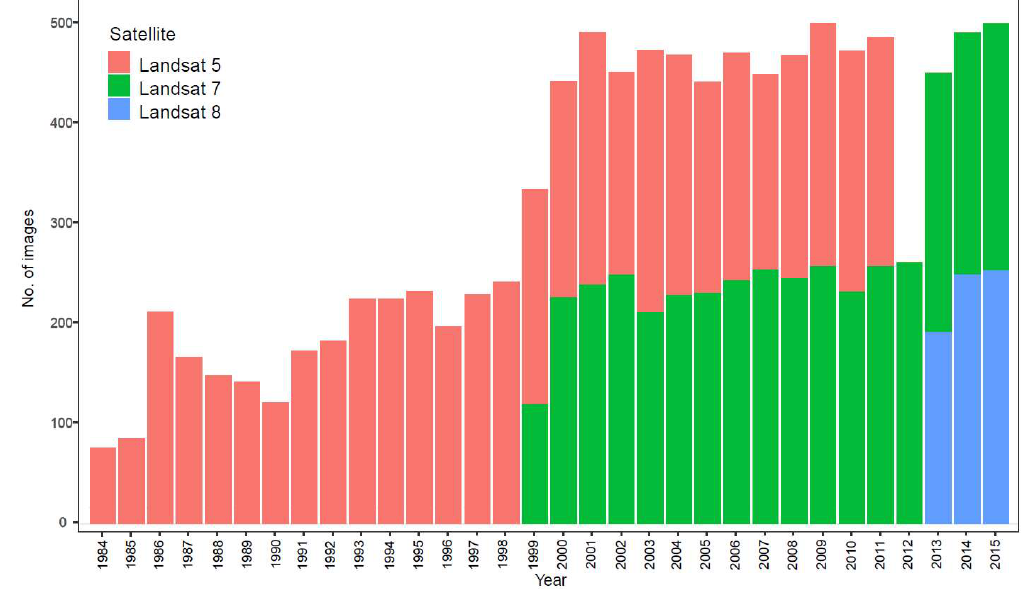
Figure 2. Number of Landsat images (<60% cloud cover) available for the entire Upper Rio Grande Basin (URGB) from 1984–2015. This study used images from the 1986–2015